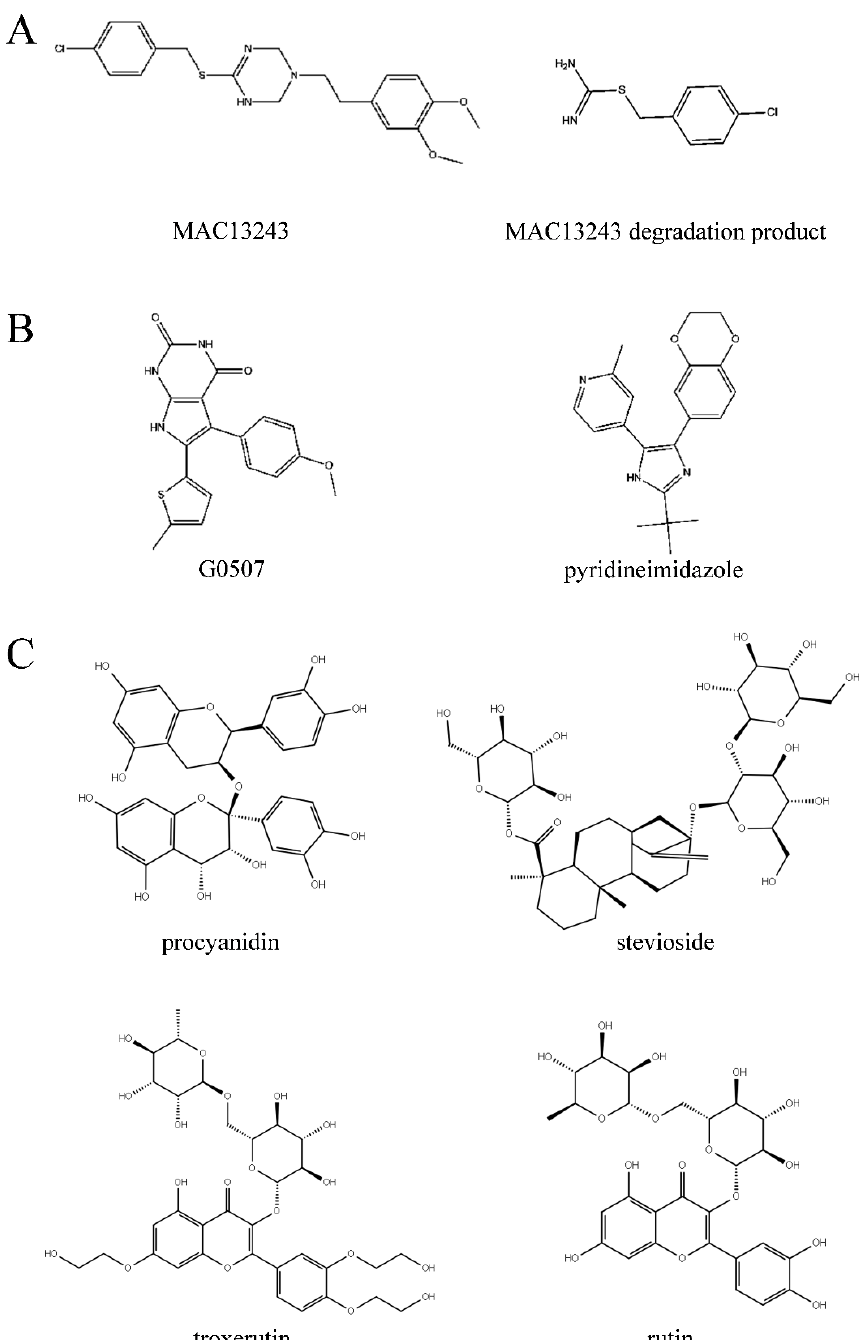
Figure 9. Chemical structures of compounds targeting Lol system. ( A ): LolA inhibitors. ( B ): LolCD 2 E inhibitors. ( C ): LolB inhibitors.